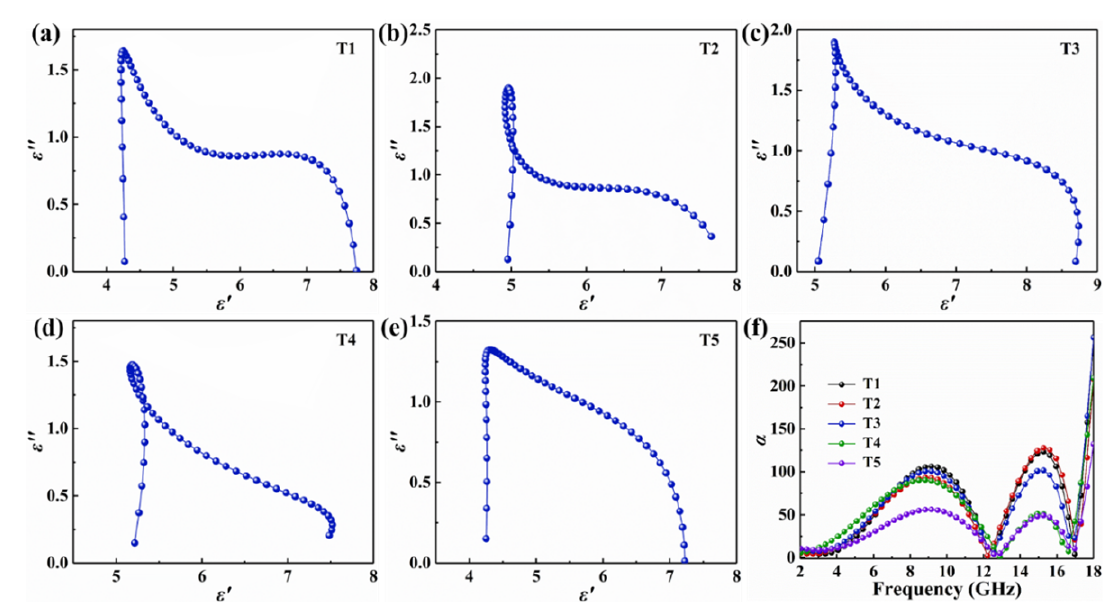
Fig. 8 Cole–Cole semicircles of (a) T1, (b) T2, (c) T3, (d) T4, and (e) T5. (f) Attenuation constants ( α ) of all samples.